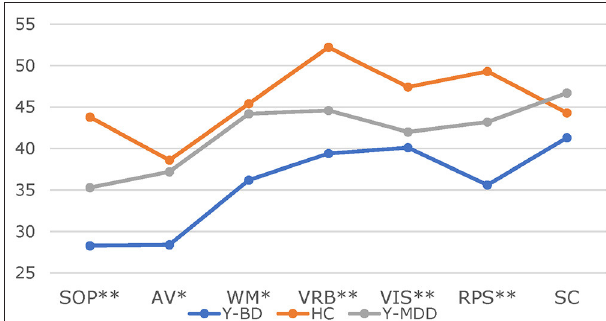
FIGURE 1 | T -scores in the seven domains between different groups. * < 0.005, ** < 0.001. SOP, Speed of processing; AV, attention/vigilance;